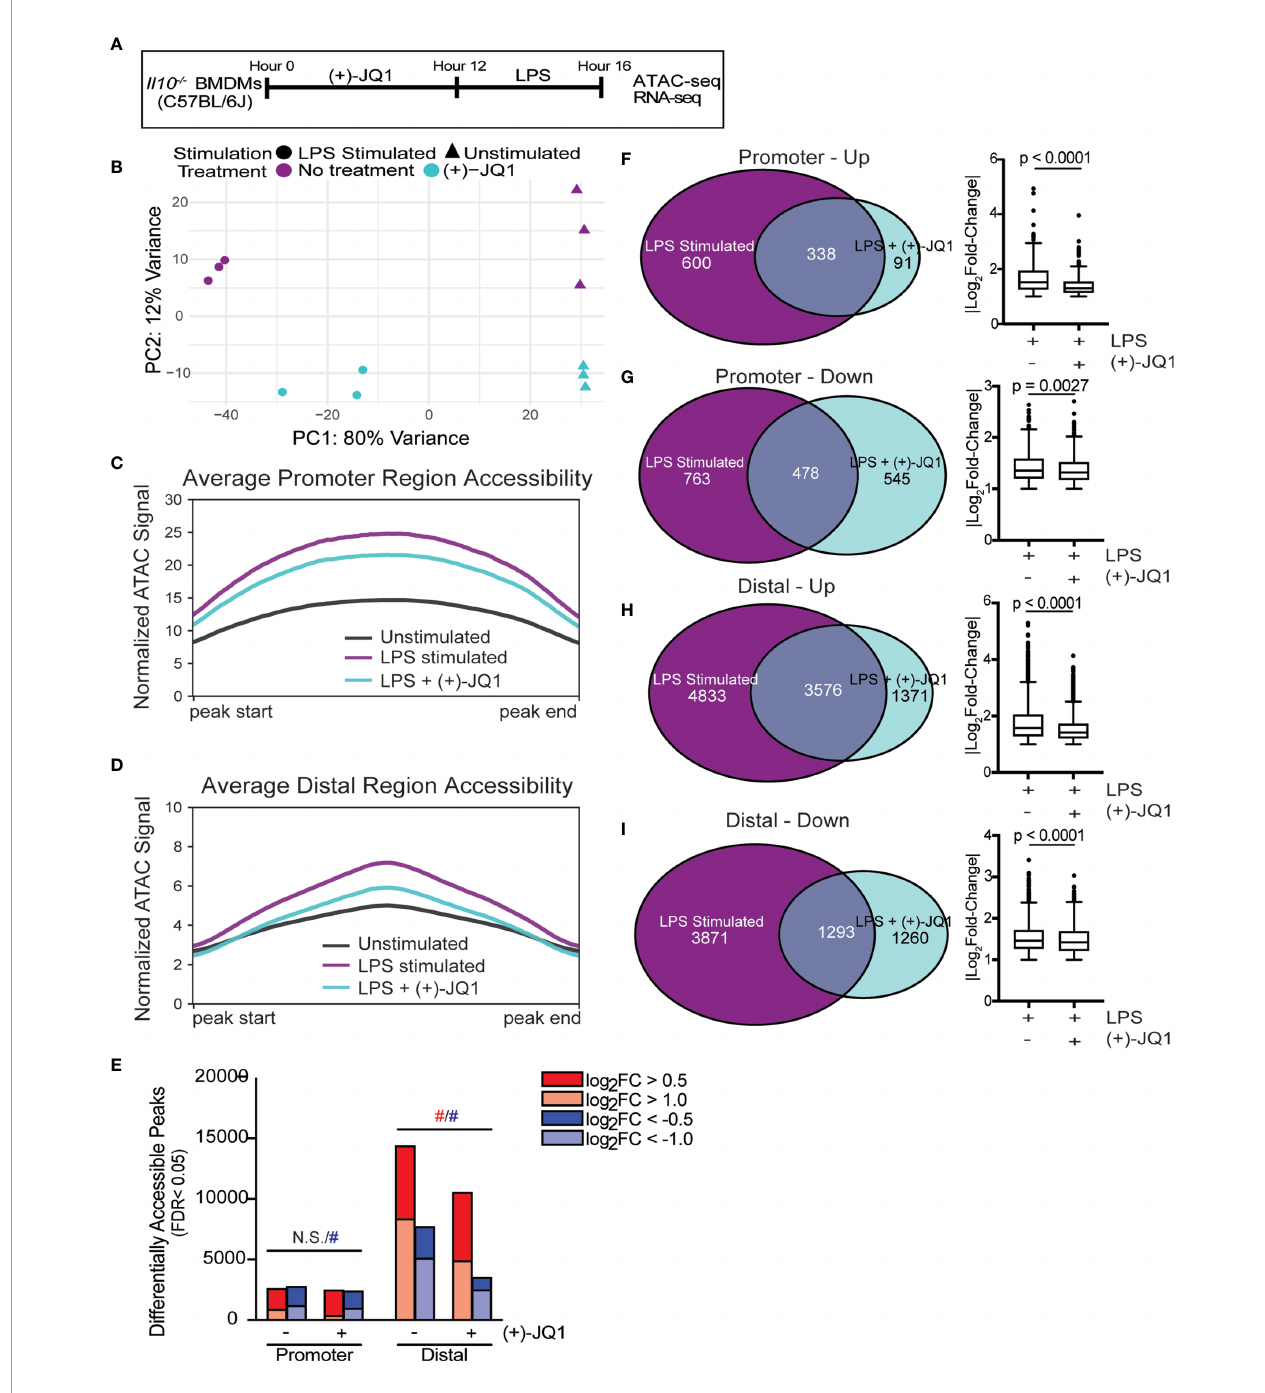
FIGURE 1 | (+)-JQ1 treatment prevents LPS-induced chromatin accessibility changes in distal regions. (A) Schematic of experimental work fl ow. (B) Principle component analysis (PCA) of chromatin accessibility pro fi les for samples that remained unstimulated (triangles) or were stimulated with LPS (circles) in the absence (purple) or presence (aqua) of (+)-JQ1. Average chromatin accessibility signal pro fi les for (C) promoter regions (-1000/+100 bases) and (D) distal regions for unstimulated (black), LPS stimulated (purple) and LPS + (+)-JQ1 (aqua) samples. (E) Identi fi cation of regions that differentially increase (red) or decrease (blue) in accessibility during LPS stimulation with or without (+)-JQ1 as compared with unstimulated BMDMs at promoter (left) and distal (right) regions (FDR < 0.05). Red and blue hashtags indicate difference in the number of regions with increased (red) or decreased (blue) accessibility with (+)-JQ1 is statistically signi fi cant using a chi- square test. Identi fi cation of peaks shared with |log 2 fold-change >1| (left) and comparison of average log 2 fold-change values using Wilcoxon sum rank tests for (F) promoters increasing in accessibility, (G) promoters decreasing in accessibility, (H) distal regions increasing in accessibility, and (I) distal regions decreasing in accessibility. FDR adjusted P values determined using DESeq2. N = 3 biological replicates. N.S. stands for Not Signi fi